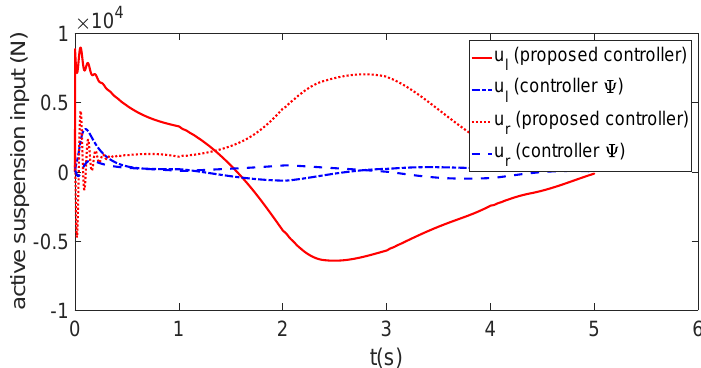
Figure 17. Active suspension input.